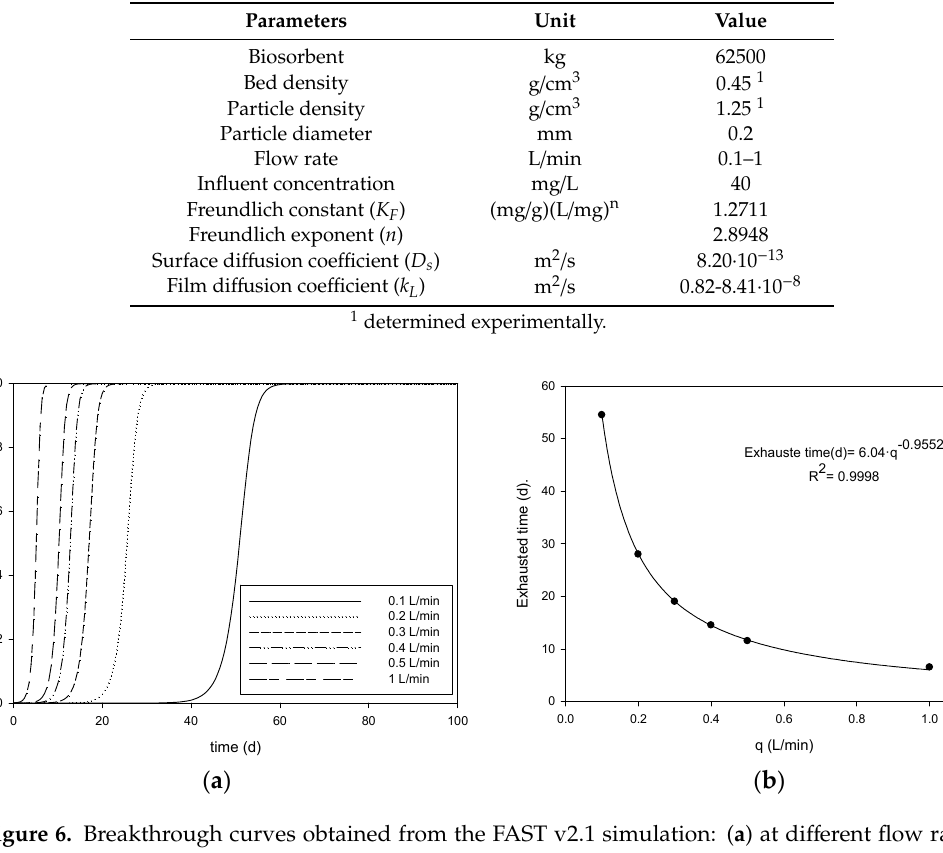
Table 5. Parameters required for the simulation using FAST V2.1 model.